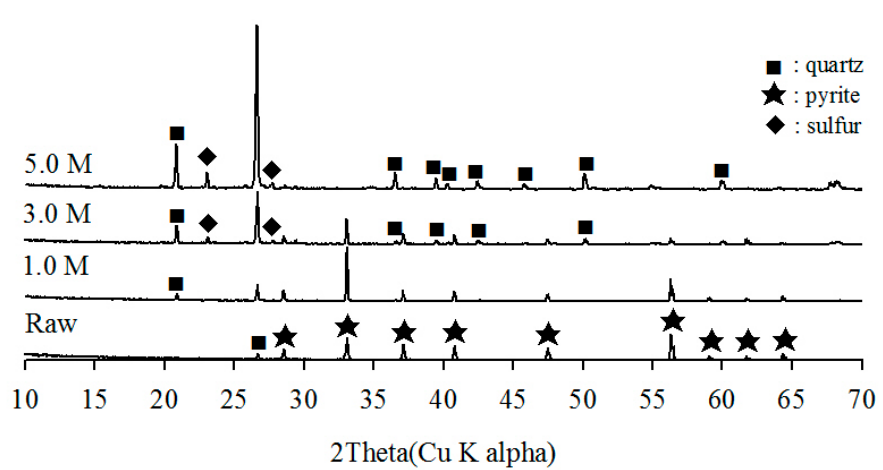
Figure 15. XRD patterns of raw and leach residue from nitric acid leaching at 1.0, 3.0 and 5.0 M. The leaching time was 15 min.